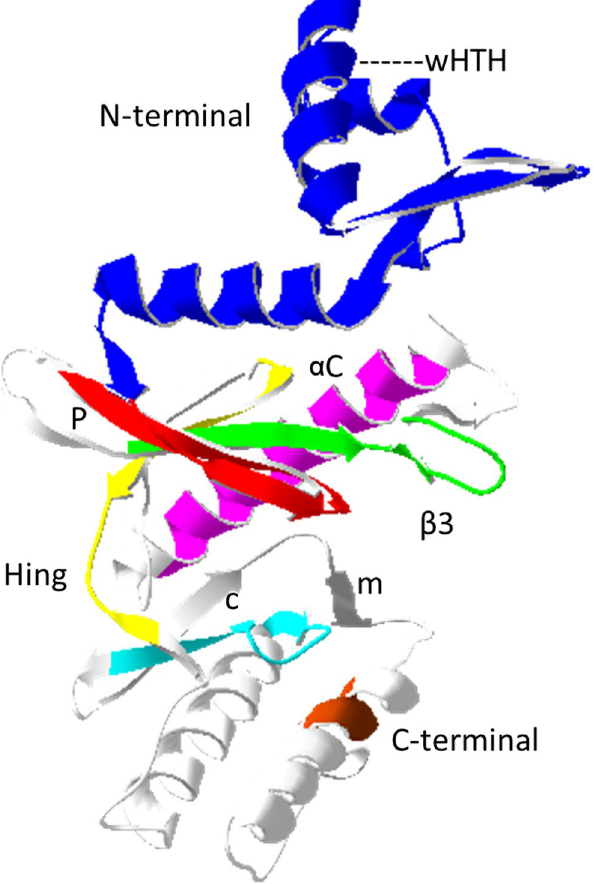
Figure 3. Homology model of the RIOK-2 protein kinase from Strongyloides stercoralis . The modeled structure of the Ss- RIOK-2 protein kinase shows different structural elements, N-terminal helix winged domain (blue), ATP binding motif (red), β 3 (green), α C (pink), Hing (yellow), active site (cyan), metal-binding loop (grey) and α I